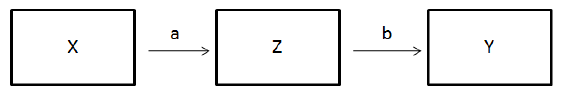
Figure 4. Variable-based model showing full mediation.